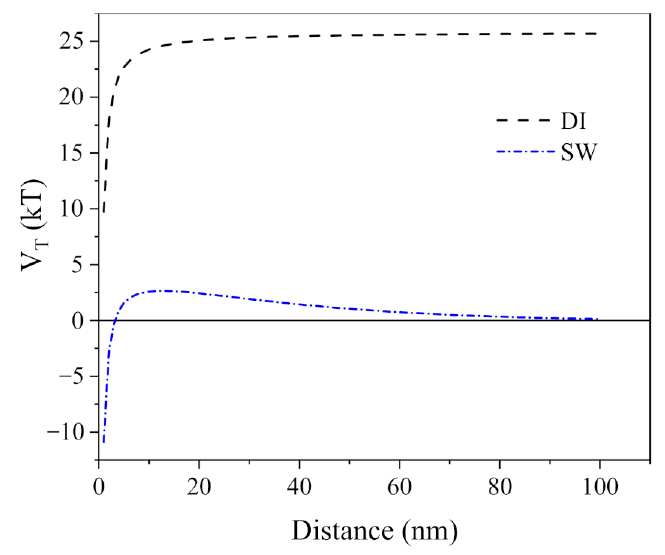
Figure 6. The DLVO interaction energy spectrum of DI and SW (pH = 8.7, IS = 100 mM) diluted cit − AgNPs.